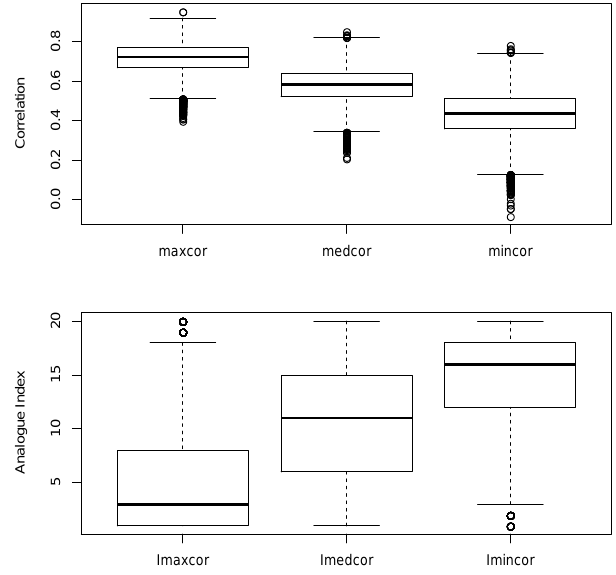
Fig. 2. Upper panel: distribution of maximum (maxcor), median (medcor) and 20th (mincor) rank spatial correlations of the 20 ana- logues. Lower panel: analogue rank (between 1 and 20) for maxi- mum (lmaxcor), median (lmedcor) and 20th (lmincor) spatial rank